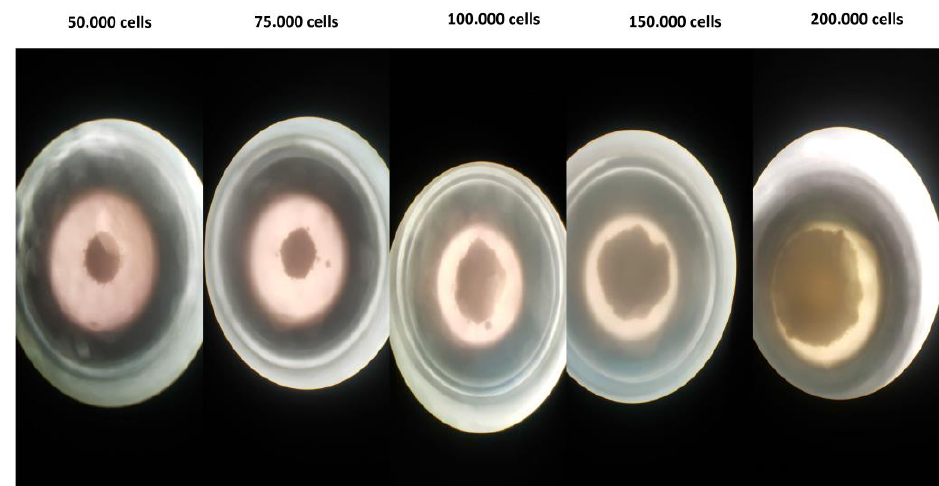
Figure 10. Spheroid images of 3D PC-3 cells (LEICA-DFC280 inverter microscope, 100×).